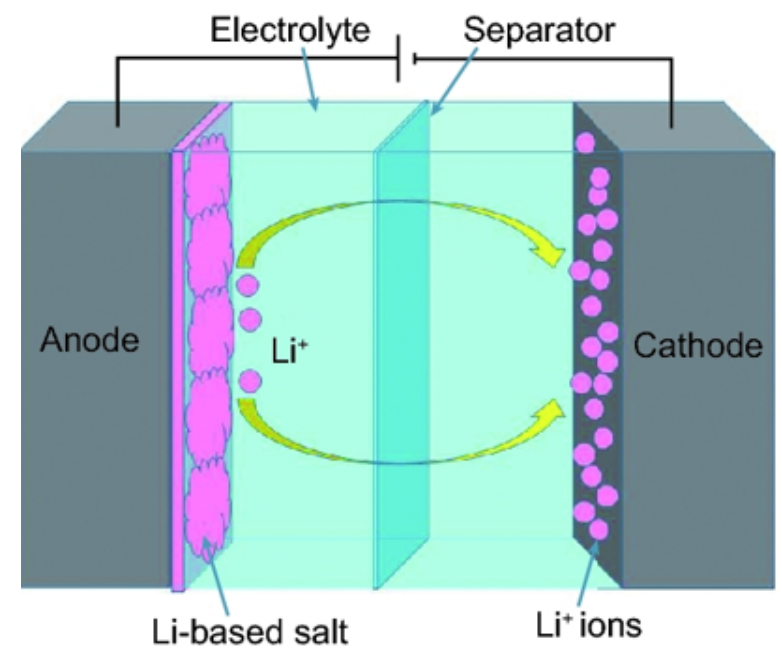
Figure 3. Schematic diagram of a hybrid supercapacitor [92]. Table 2. Summary of GR based materials for capacitor applications.